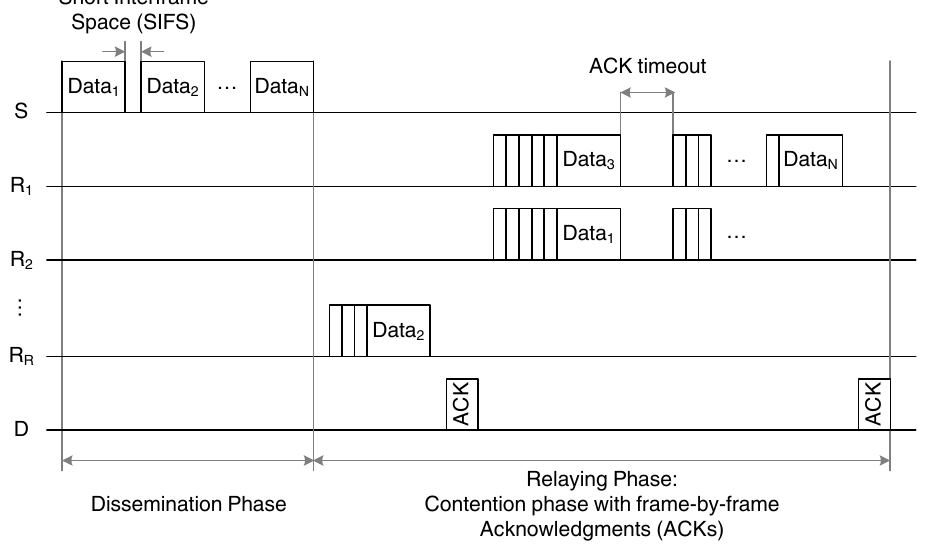
Figure 3. Example of the baseline medium access control (BS-MAC) transmission